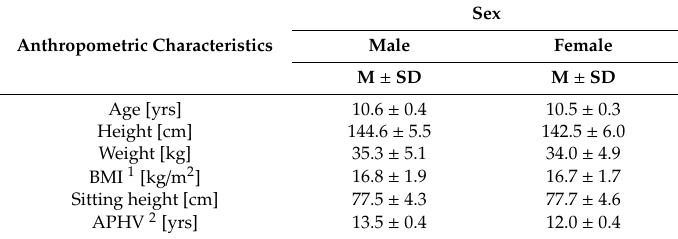
Table 1. Anthropometric characteristics of male and female athletes at the start of the